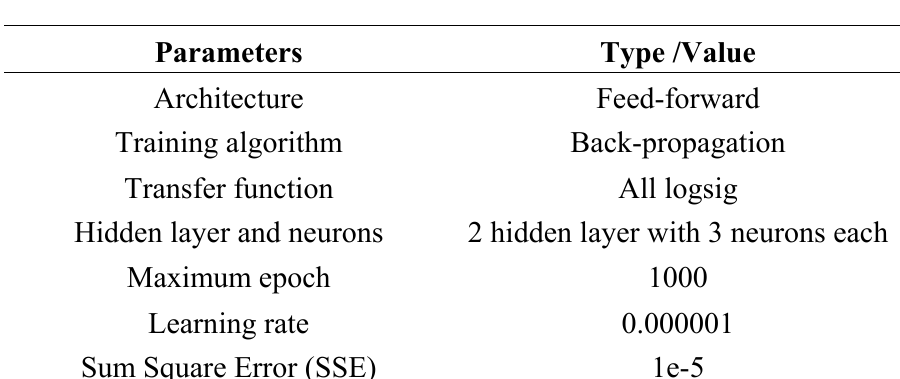
Table 3. Architecture of the